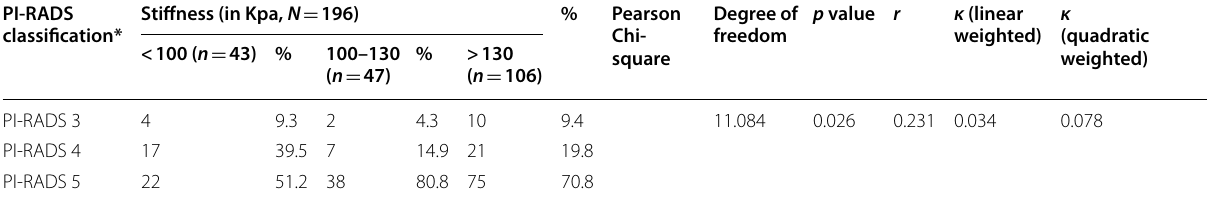
* PI-RADS classification 3 means intermediate probability of clinically significant prostate cancer, 4 means high probability of clinically significant prostate cancer and 5 means very high probability of clinically significant prostate cancer